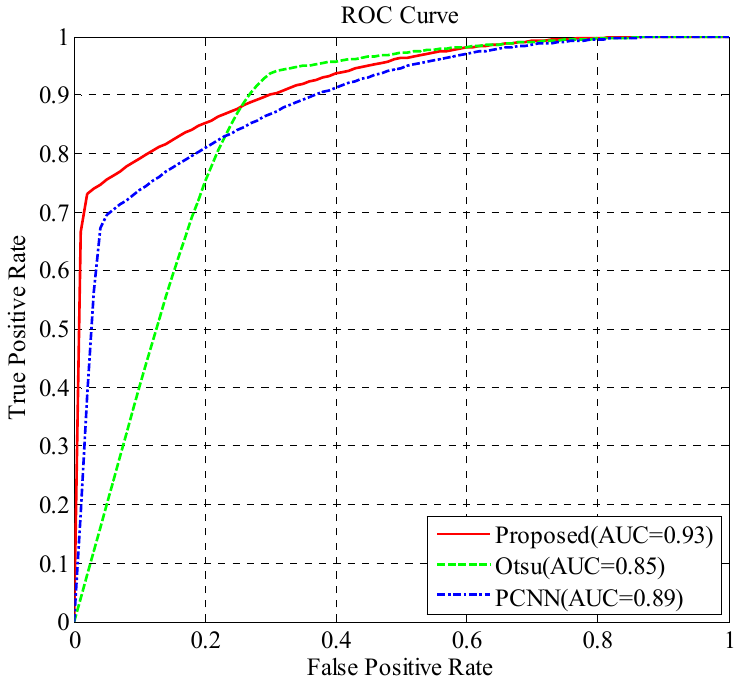
Figure 11. Receiver operating characteristic (ROC) curve of the detection results from different experimental methods.